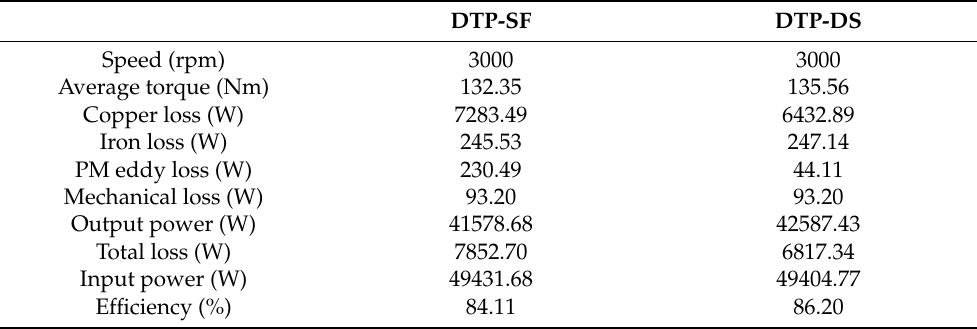
Table 10. Loss and efficiency of different winding configurations under three-phase OC maximum torque condition.